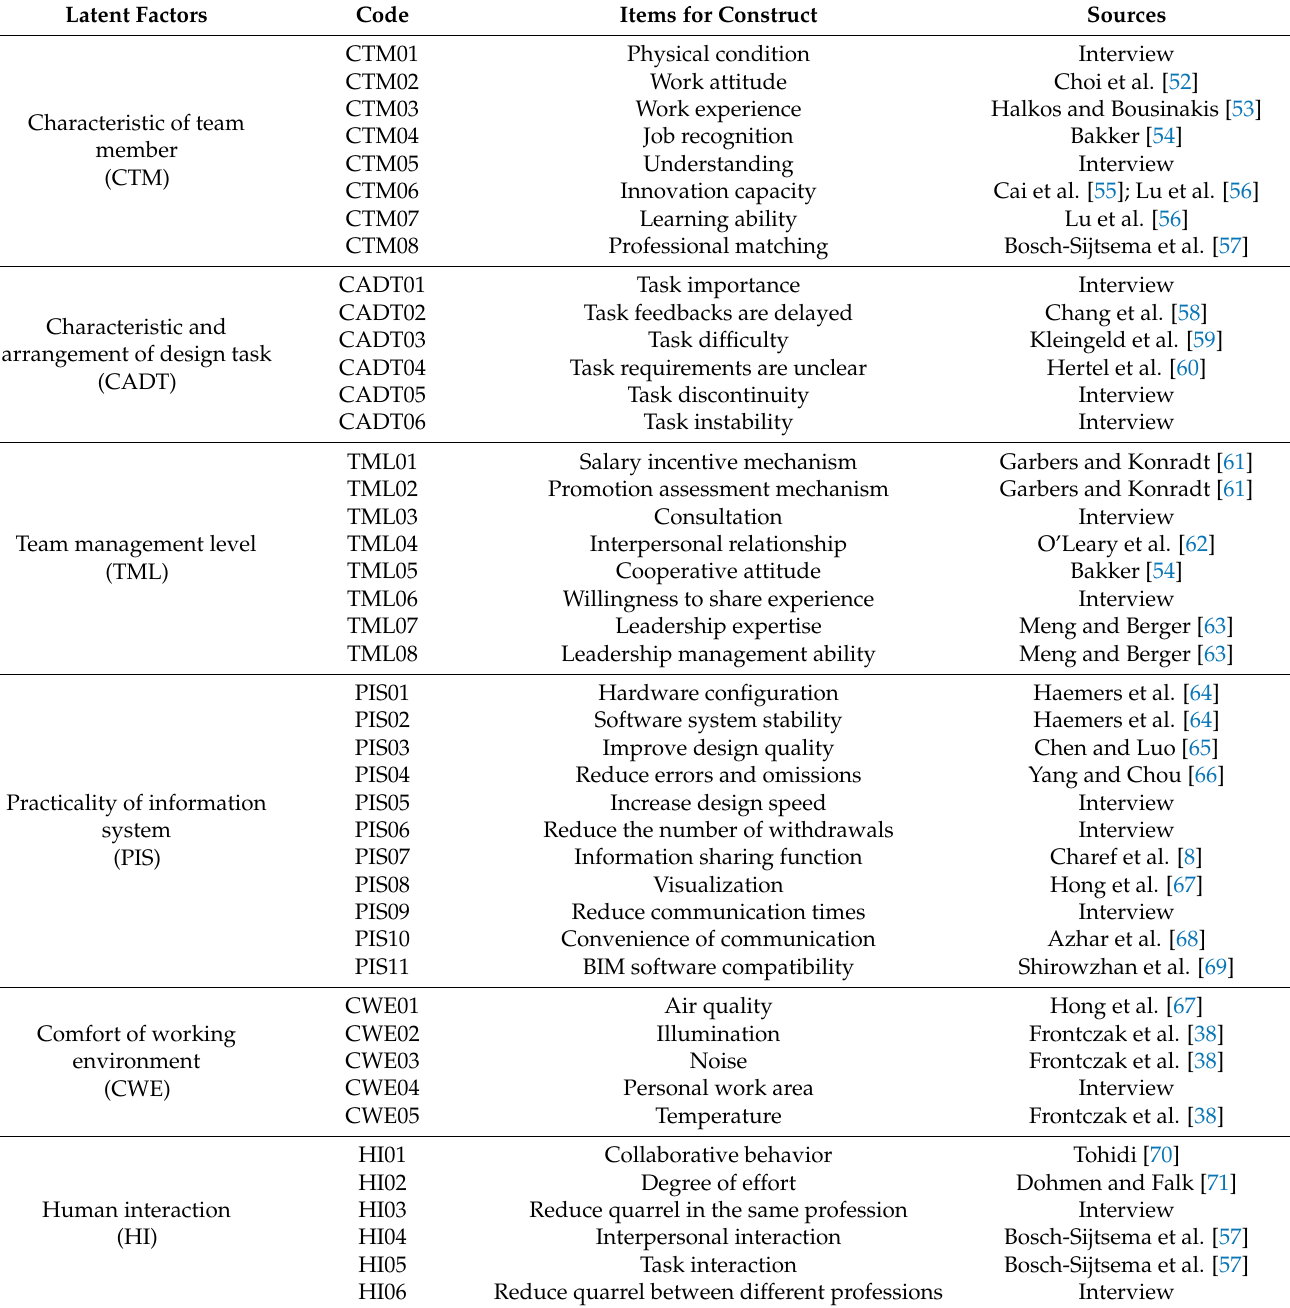
Table 1. Factors and measurement items for teamwork efficiency in BIM-based collaborative